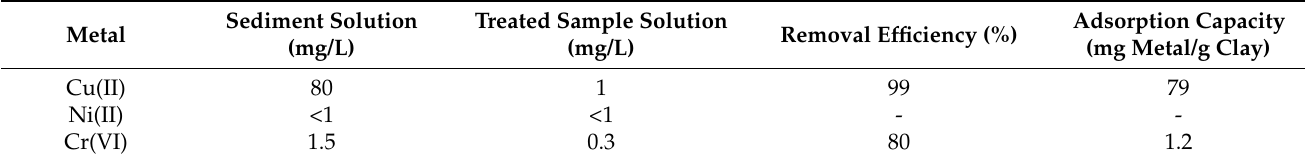
Table 6. Adsorption